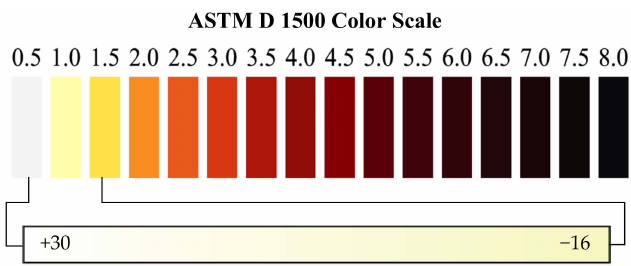
Figure 4. Saybolt color scale with ASTM D 1500 color scale.